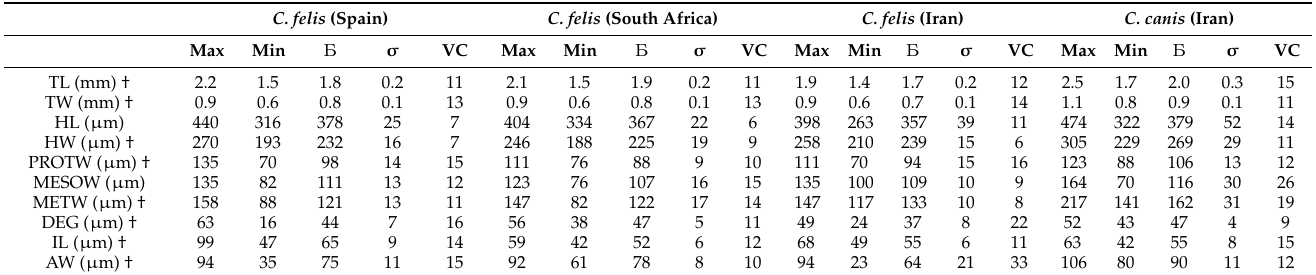
Table 2. Biometrical data of males of Ctenocephalides felis and C. canis isolated from Canis lupus familiaris from Spain, South Africa and